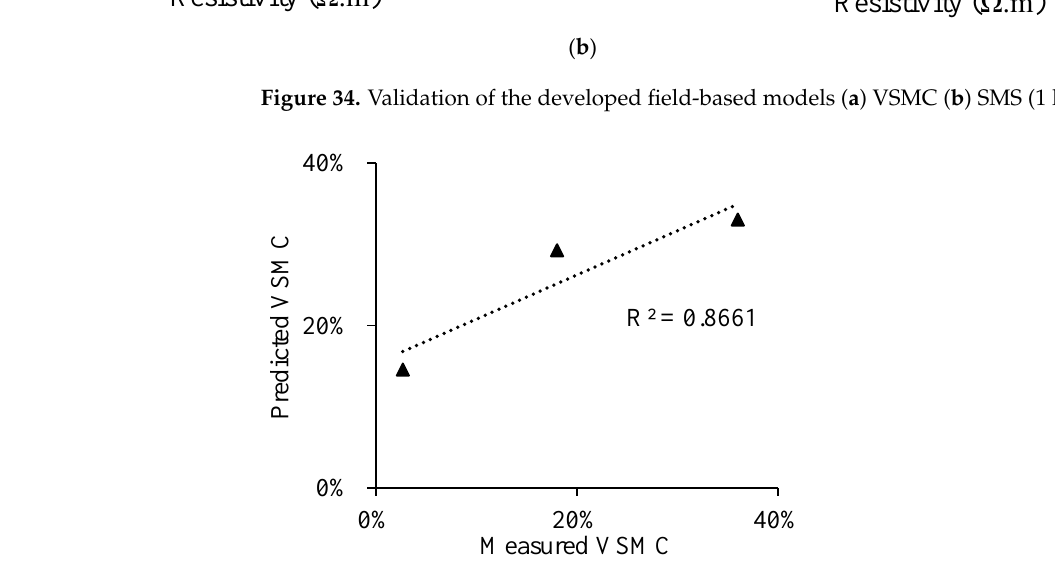
Figure 35. VSMC field-based model prediction accuracy.